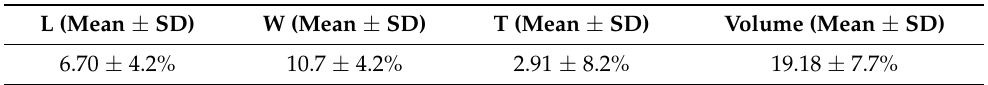
Table 2. Shrinkage. Length (L), width (W), thickness (T), and ellipsoid volume (V) reduction (in %) after optical clearing were measured on seven mouse